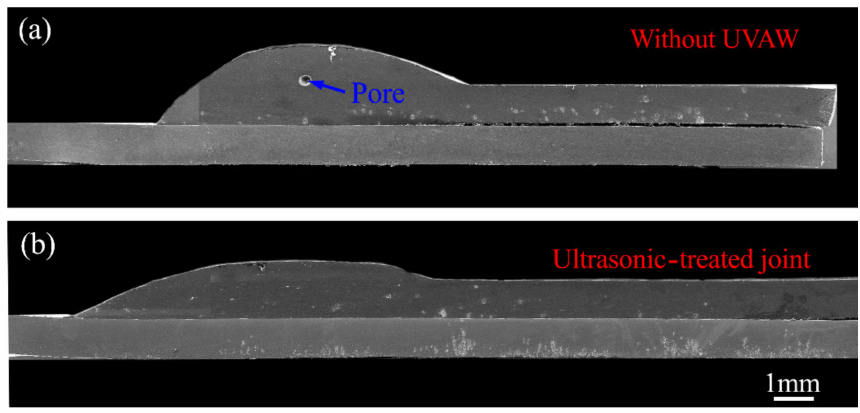
Figure 4. The typical cross-sectional area of weldments obtained with and without UVAW: ( a ) current